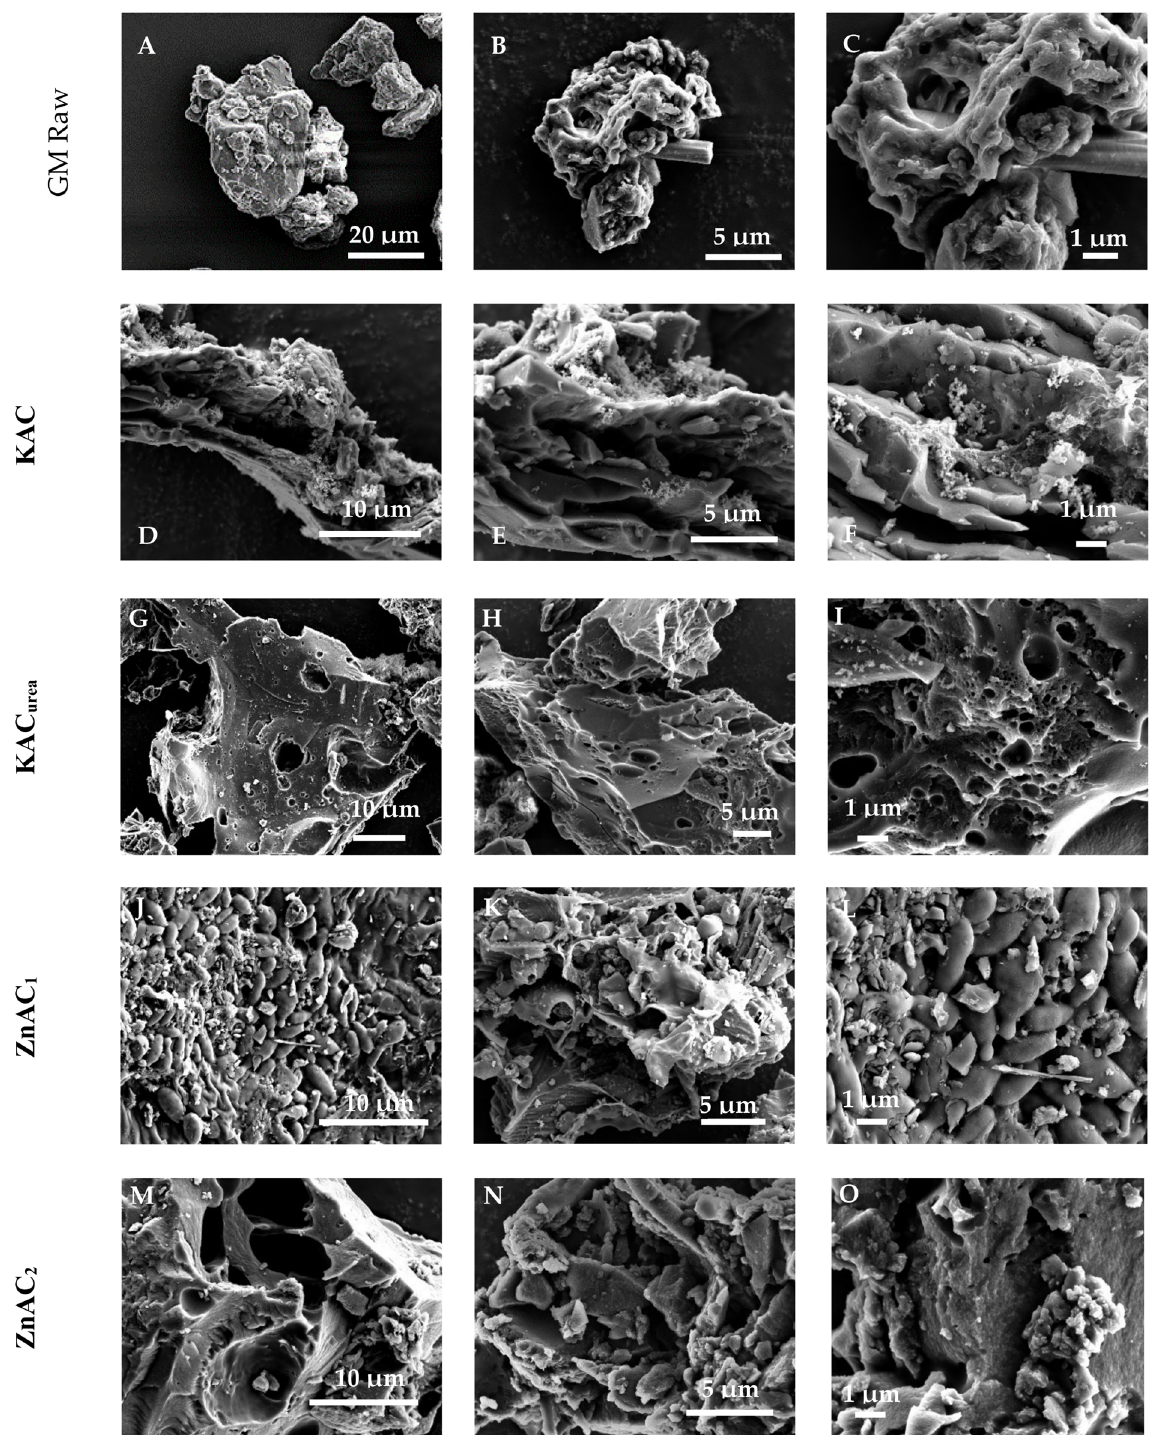
alities from the urea-mixed GM evolved into gaseous species around 520 °C [32], increas- ing the defect sites and mesopores of KAC urea compared to KAC, as visible in Figure 2D–F. In the case of the ZnCl 2 activating agent, ZnAC 1 (Figure 2J–L) showed a stacked granular morphology with a very low number of pores on the surface. In comparison, ZnAC2 (Figure 2M-O) shows large cavities on the surface with some small pores embedded.